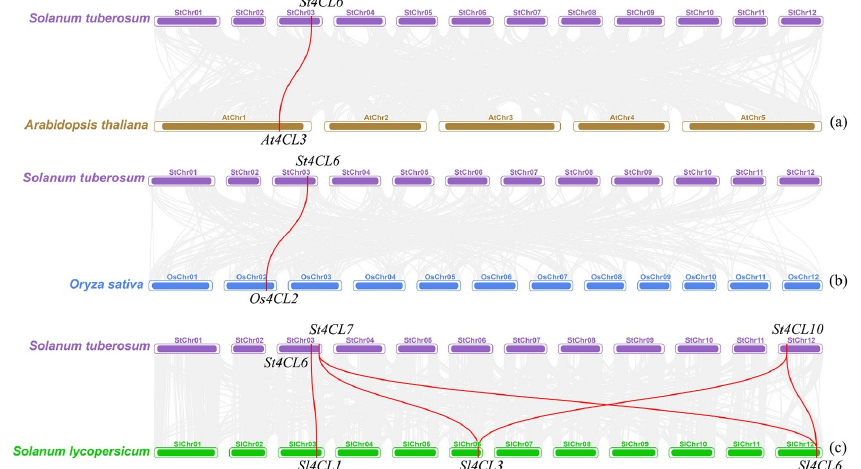
Figure 5. 4CL genes in rice ( Oryza sativa ), potato ( Solanum tuberosum ), Arabidopsis thaliana and tomato ( Solanum lycopersicum ) were analyzed for collinearity. ( a ) 4CL genes in potato and Arabidopsis were analyzed for collinearity. ( b ) 4CL genes in potato and rice were analyzed for collinearity. ( c ) 4CL genes in potato and tomato were analyzed for collinearity. Gray lines represent regions where collinearity exists between rice, potato, Arabidopsis and tomato. The red lines were used to connect genes for which collinearity existed between rice, potato, Arabidopsis, and tomato.